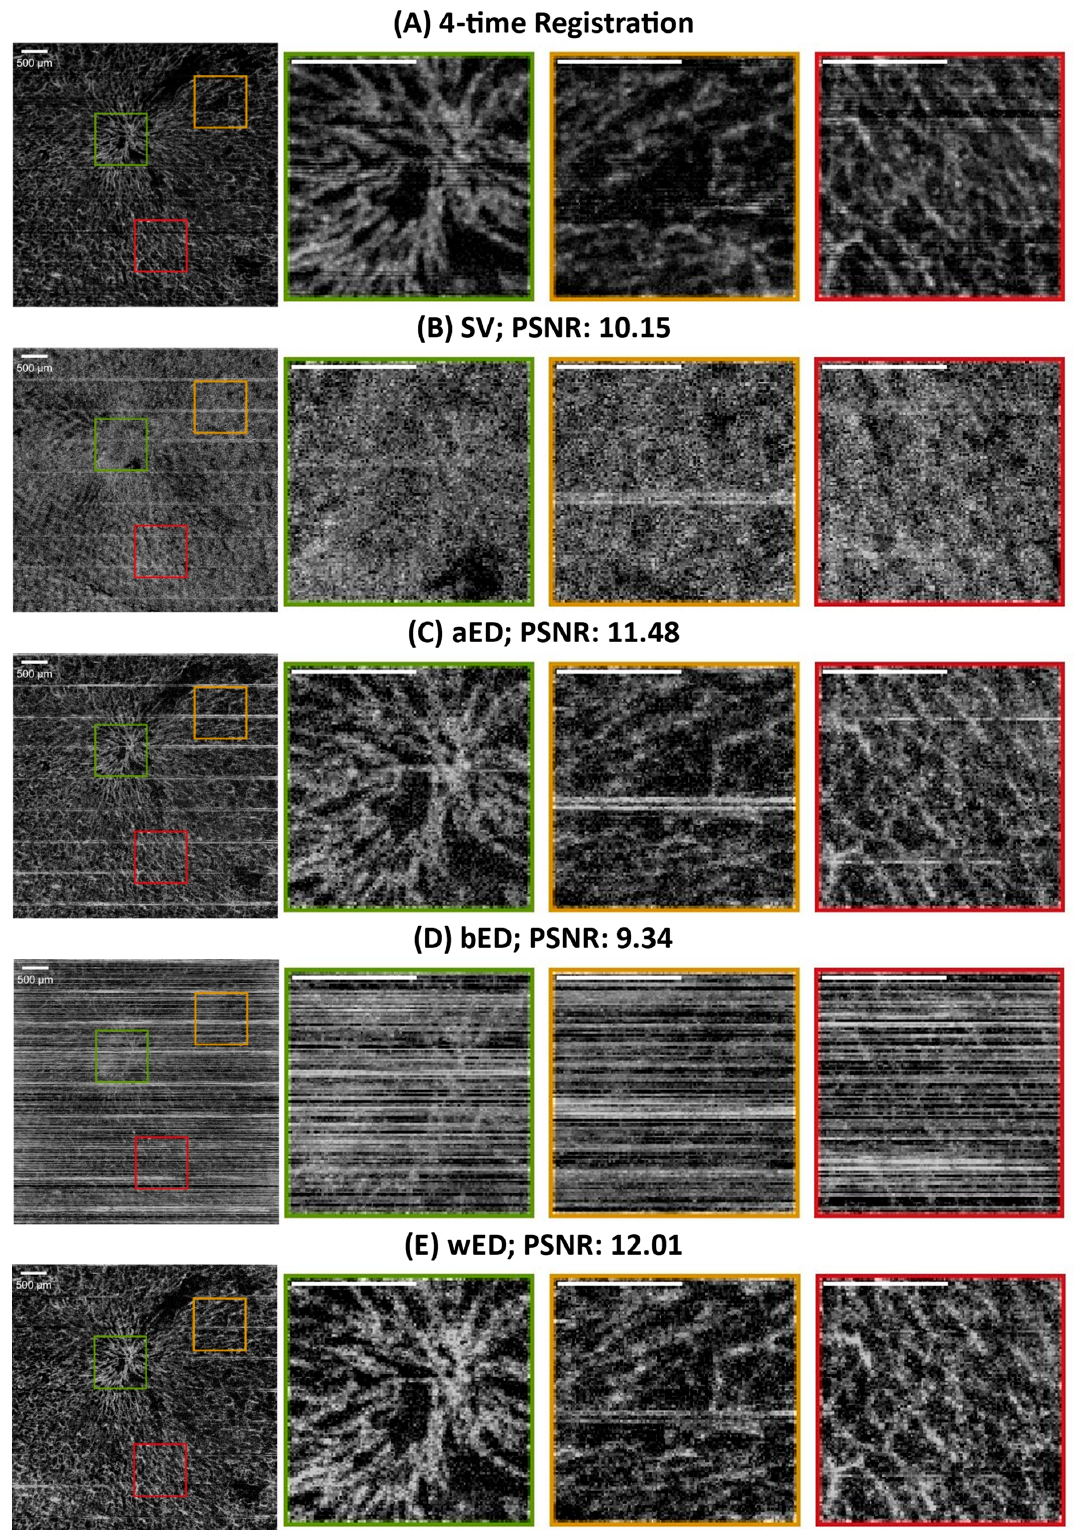
Figure 5. The comparisons of en face results from maximum intensity projection using different algorithms. ( A ) Registration from 4-time acquisitions; ( B ) SV; ( C ) aED; ( D ) bED; ( E ) wED. (All scale bars represent 500 μ m); SV: Speckle Variance; aED: A-scan eigen-decomposition; bED: B-scan eigen-decomposition; wED: windowed eigen-decomposition.